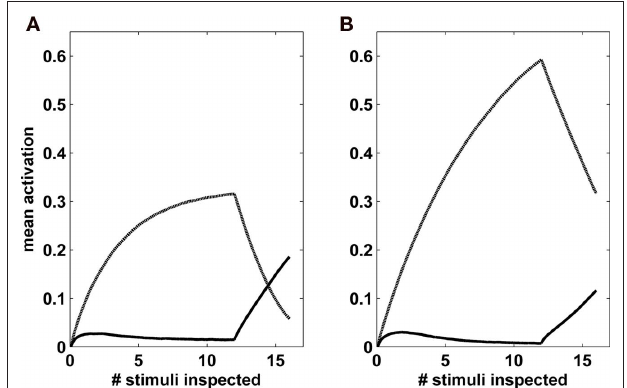
Figure 1 | Leaky competing accumulator activations in a binary task, in which the total evidence to both alternatives is equal, but is modulated in time, so that the first accumulator (dashed line) receives more evidence at the beginning (first 12 frames), while the second one (solid line), receives more evidence at the end (last 4 frames). (A) : leak dominance (leak = 0.022, inhibition = 0.01); (B) : inhibition dominance (leak = 0, inhibition = 0.025). In the first case, the accumulator receiving more evidence at the end would be chosen; in the second, the accumulator receiving more evidence at the beginning would be chosen. Reproduced from Usher and McClelland